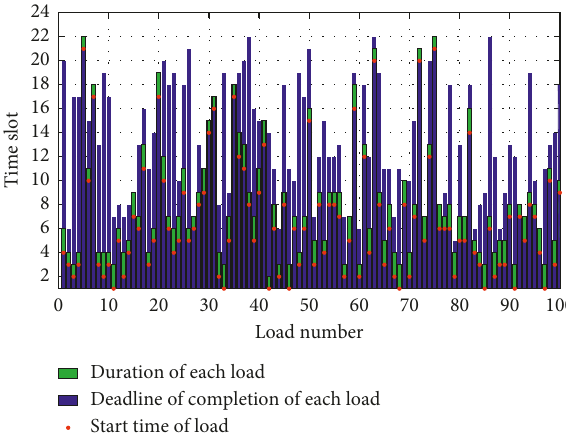
Figure 11: Initial appliance schedule for 100 appliances with the deadline of completion of the load, duration of load, and start